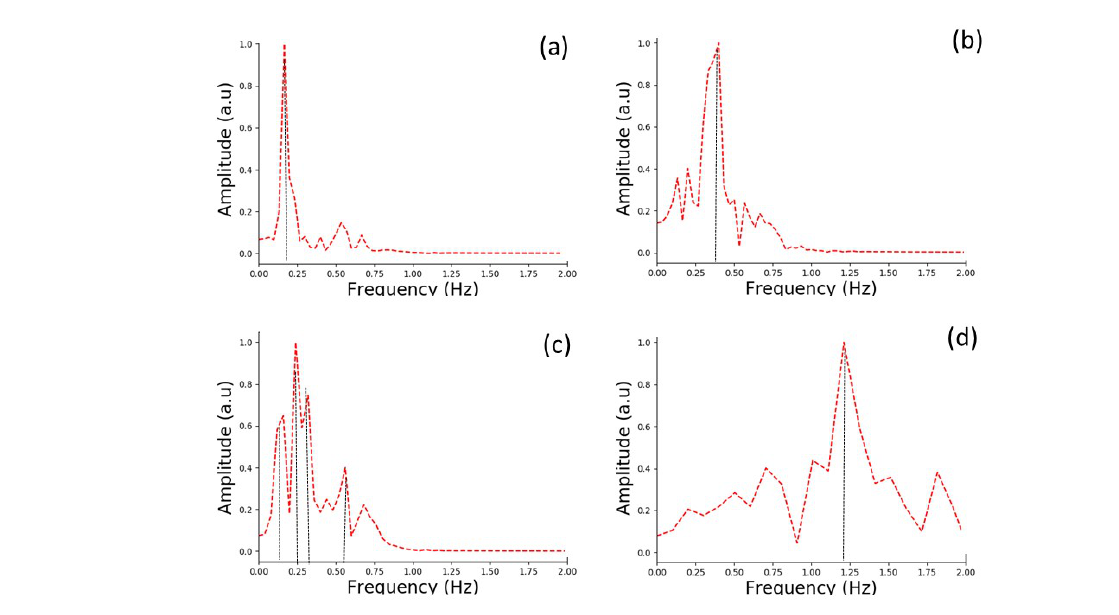
Figure 11. Output of Fourier transform for slow ( a ), shallow ( b ), irregular ( c ) and fast breathing ( d